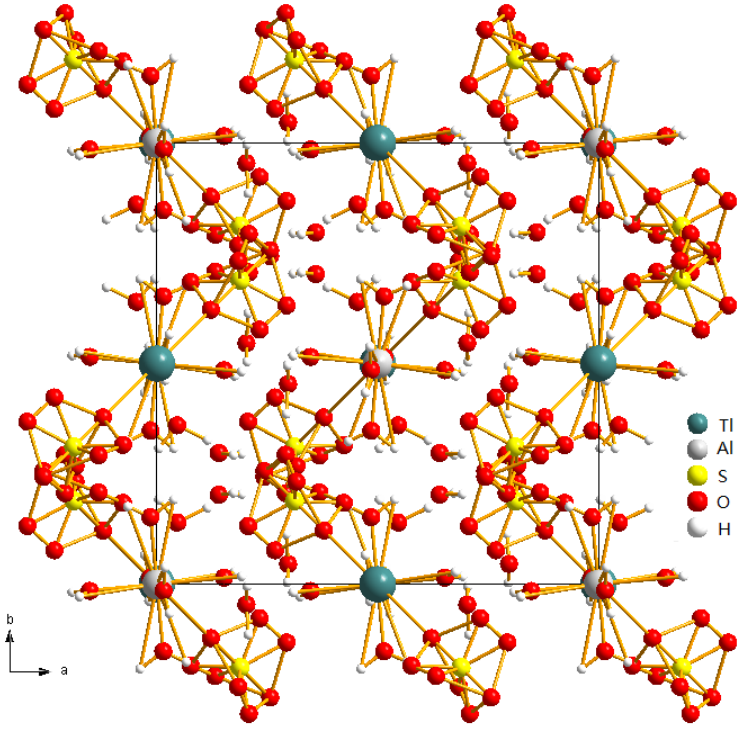
Figure 3. Crystal structure of Lanmuchangite.